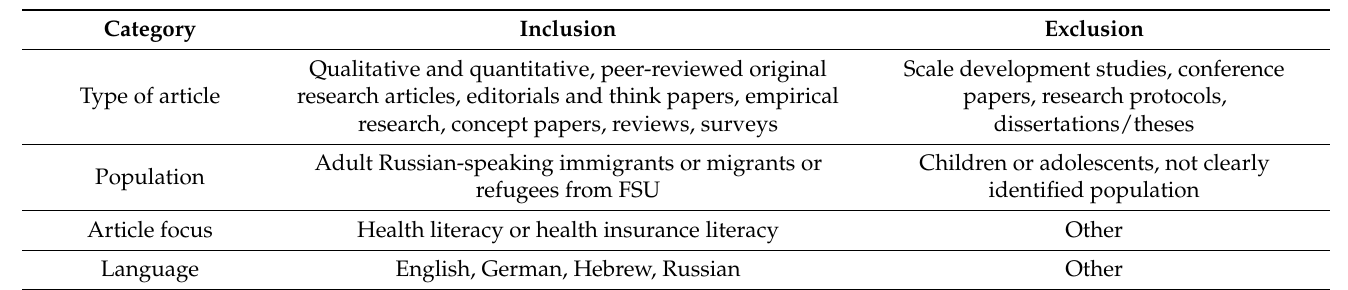
Table 1. Inclusion and exclusion